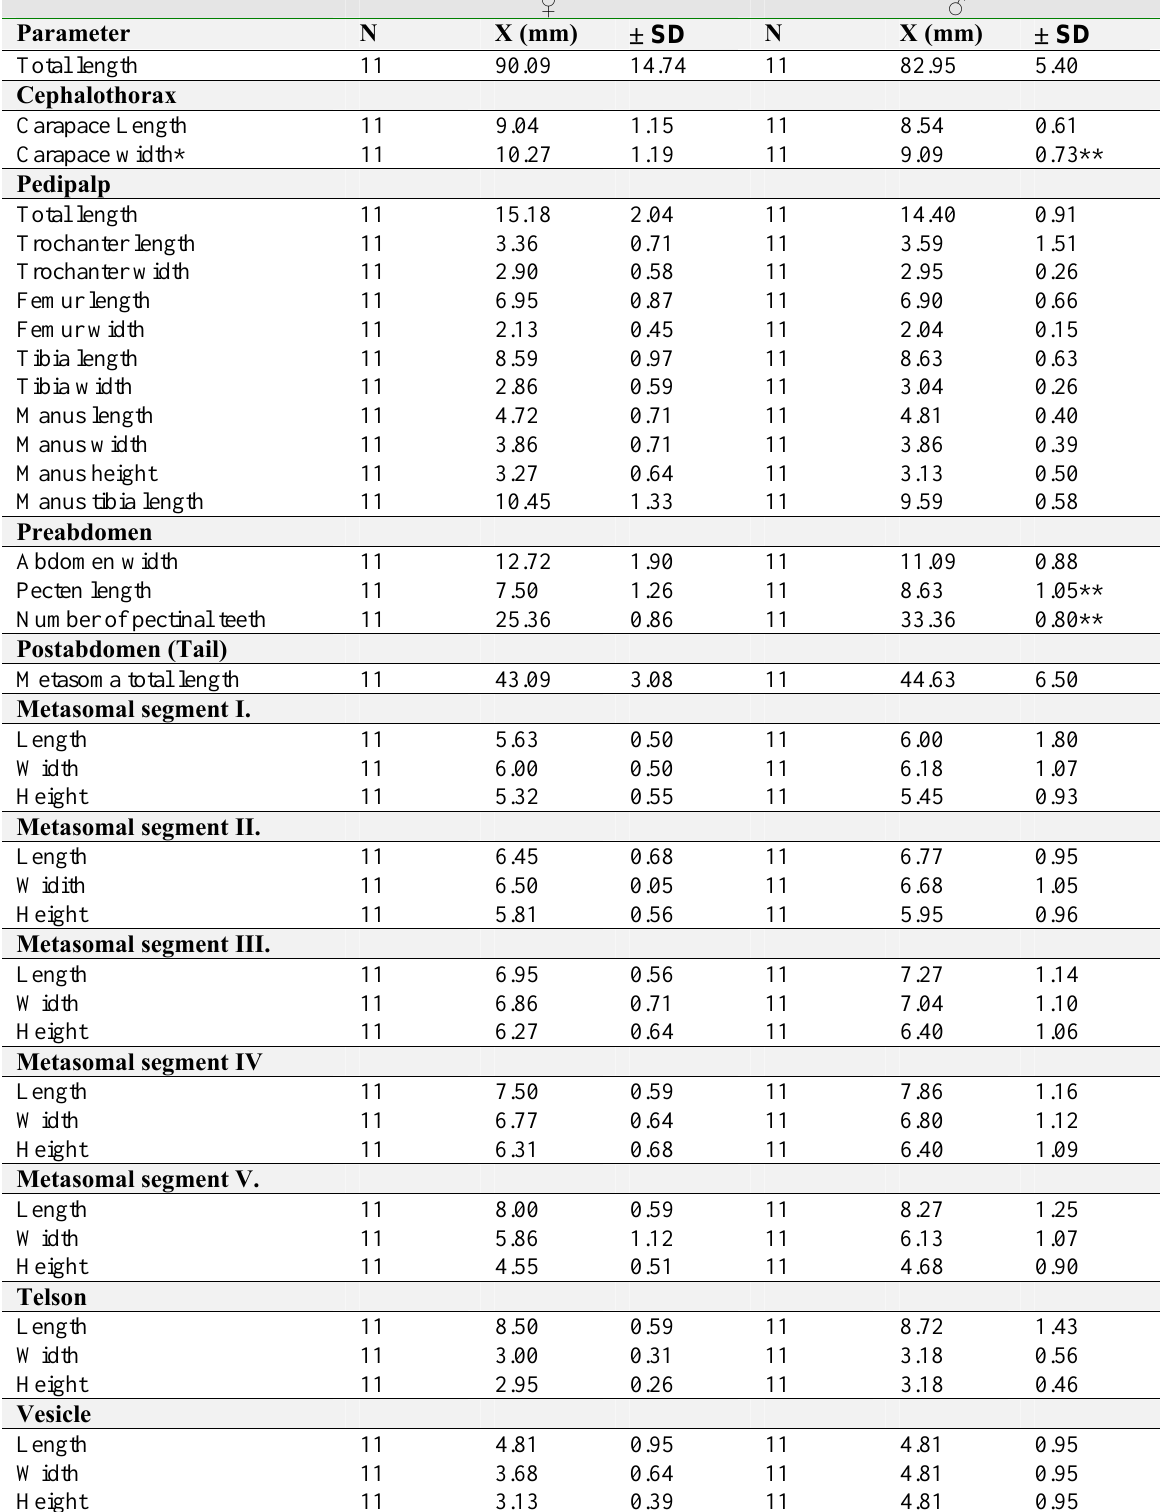
Table 1: Some morphometric measurements of female and male specimens of Androctonus crassicauda (statistically significant; p